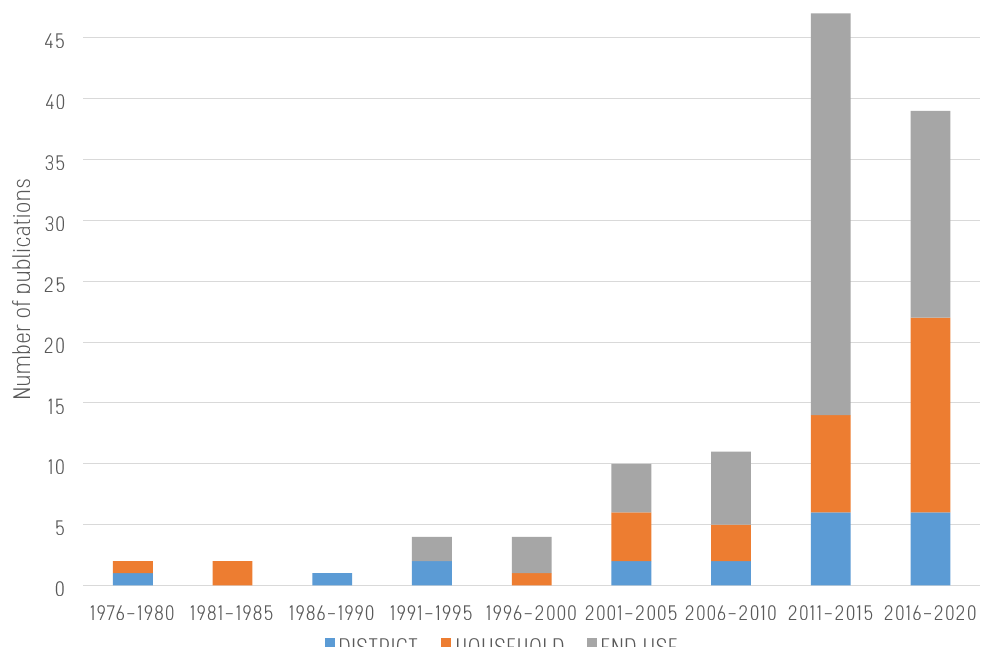
Figure 3. Five–year count of the 120 scientific publications reviewed in this study and referencing the 92 reviewed datasets.